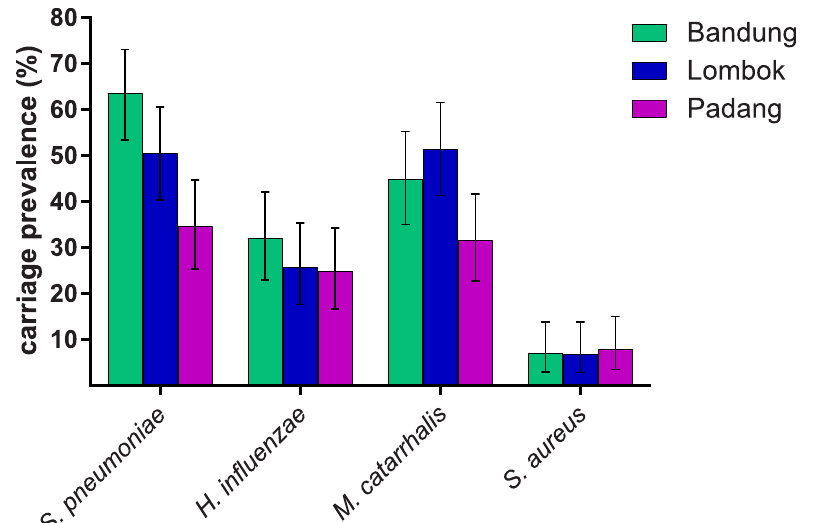
Fig 1. Nasopharyngeal carriage prevalence (%) of S . pneumoniae , H . influenzae , M . catarrhalis ,and S . aureus in Indonesian children aged 12–24 months. Results are shown by region (Bandung, Padang, and Lombok). Error bars represent 95%CI.